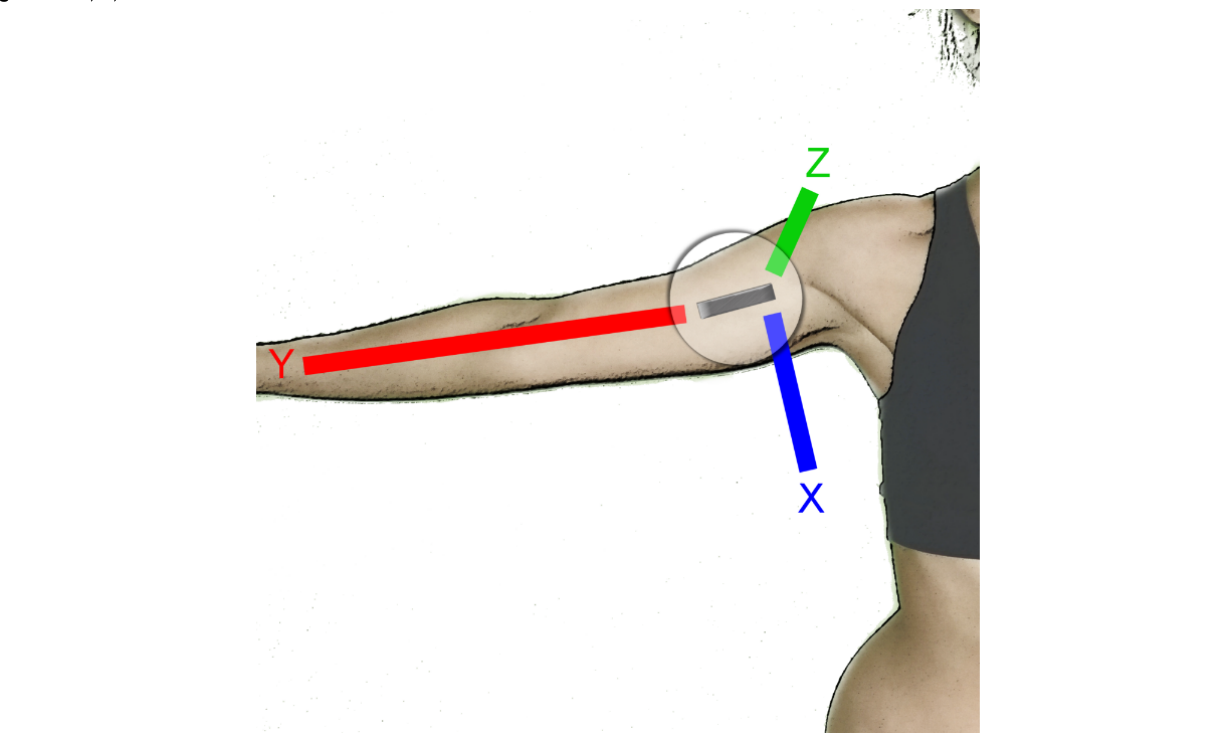
Figure 1. X, Y, and Z motion axes.